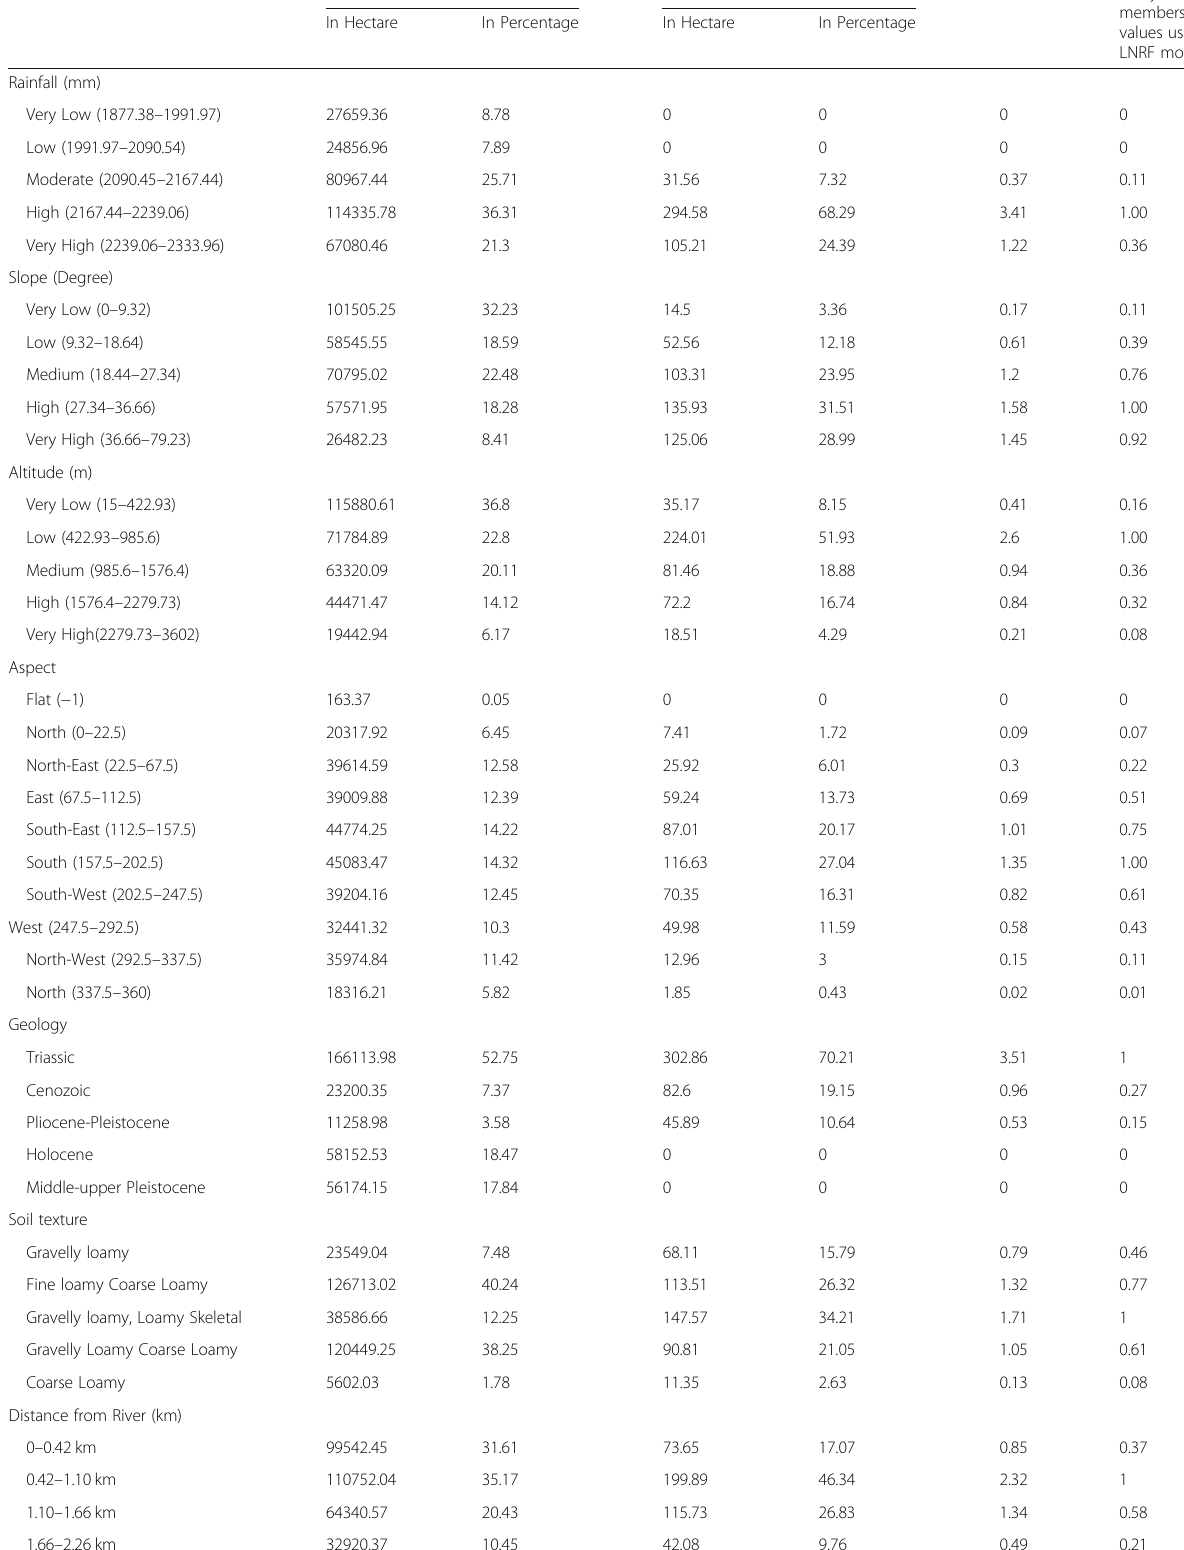
Table 3 Computation of LNRF model on landslide determining